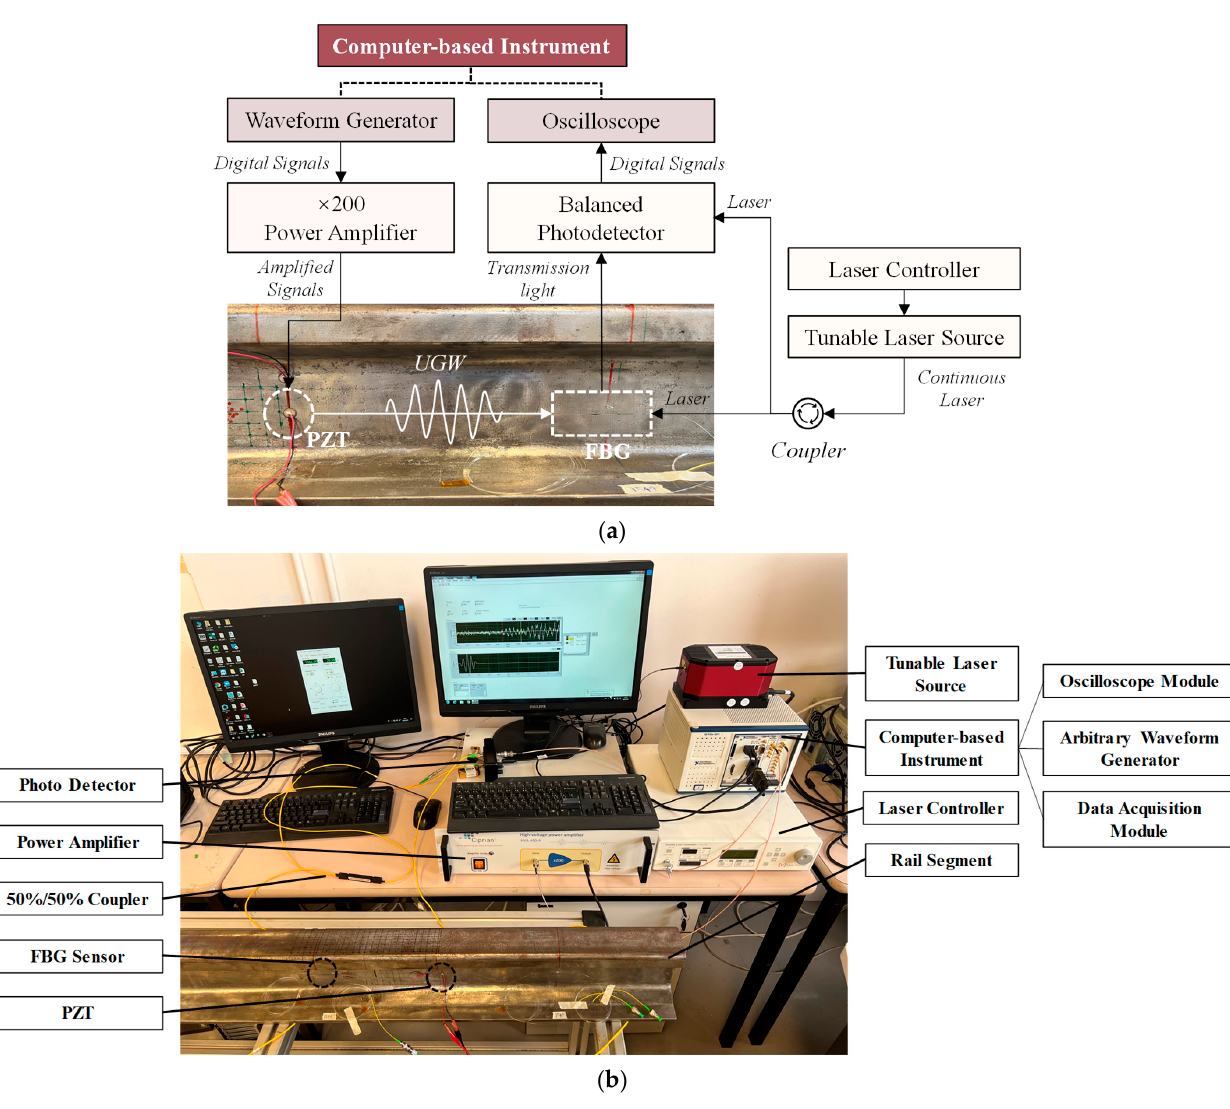
Figure 4. The experimental setup: ( a ) the schematic; ( b ) the laboratory setup.